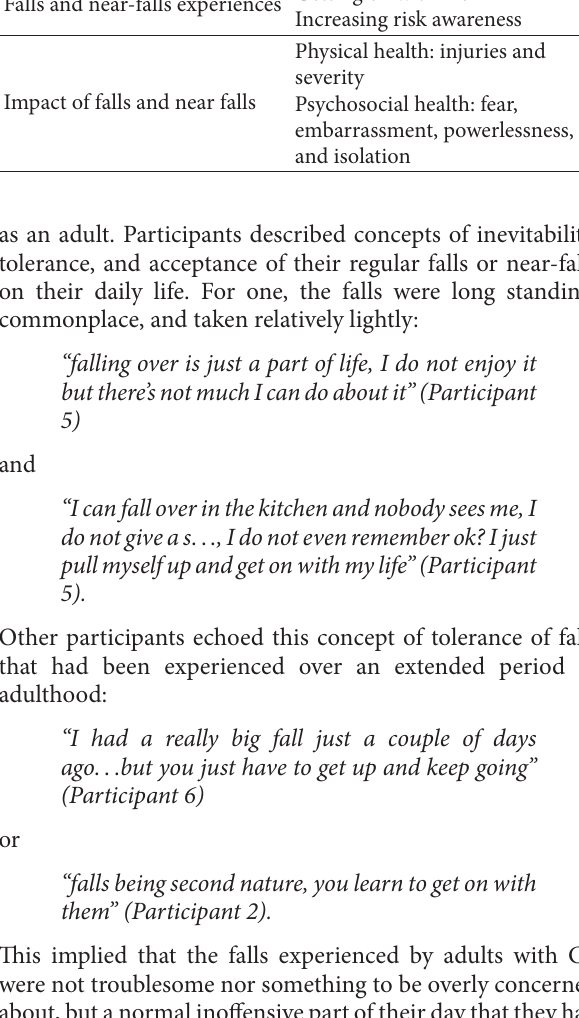
Table 2: Key themes arising from interviews. Key theme